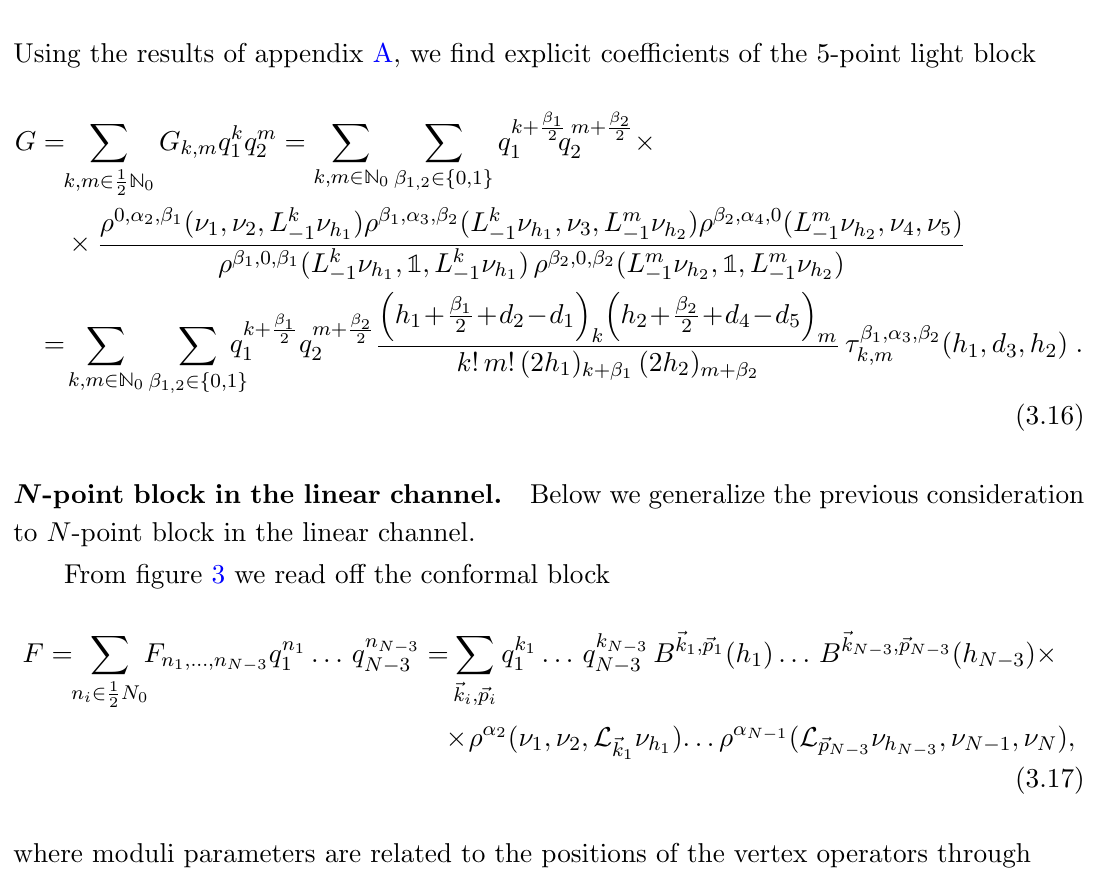
Figure 3 . N -point conformal block in the linear